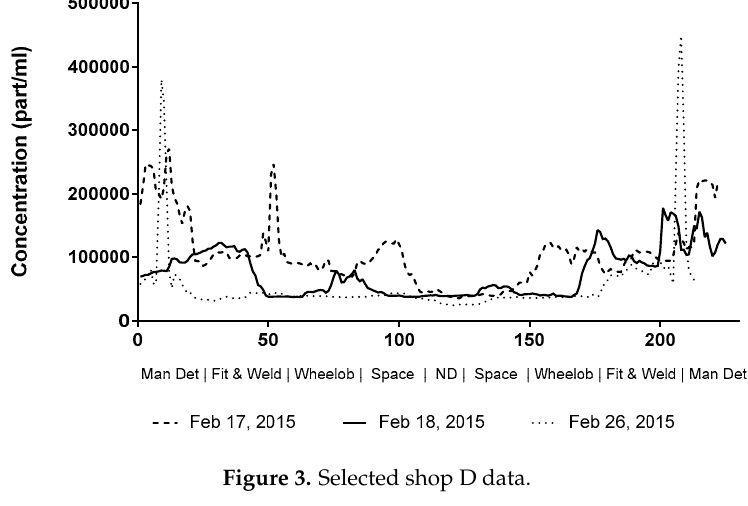
Figure 3. Selected shop D data.